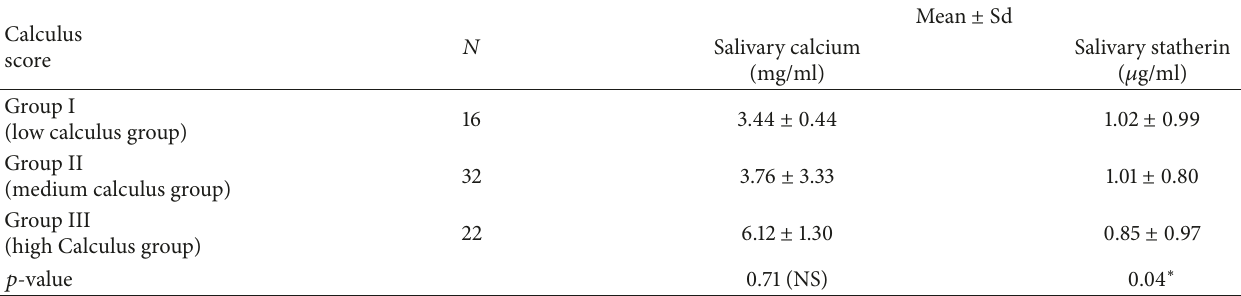
Table 2: Comparison of salivary calcium and statherin levels based on the calculus